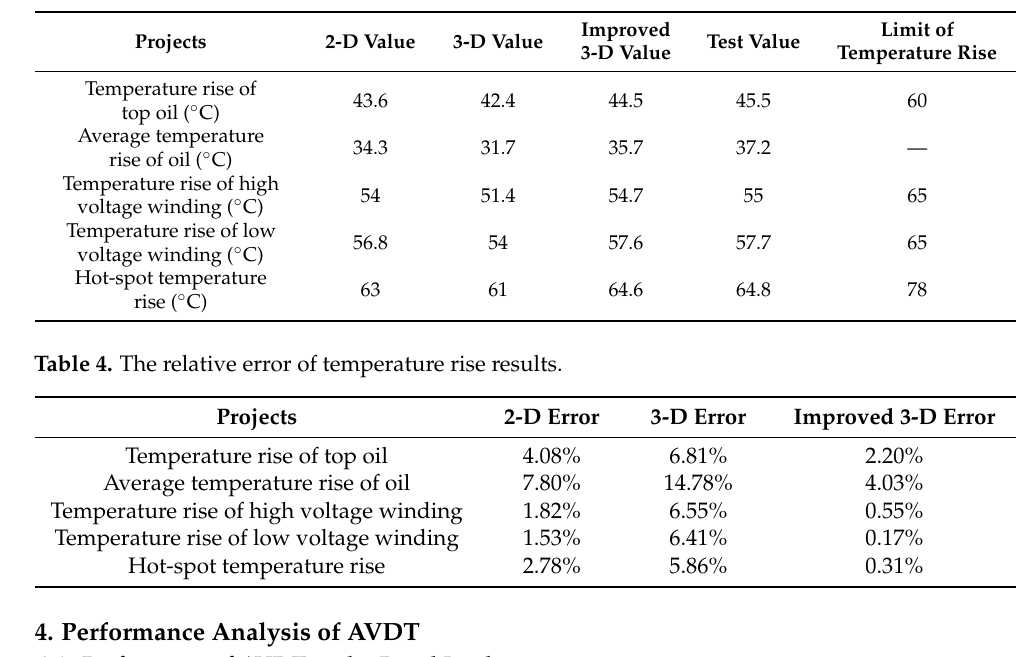
Table 3. Temperature rise calculated results and test data.